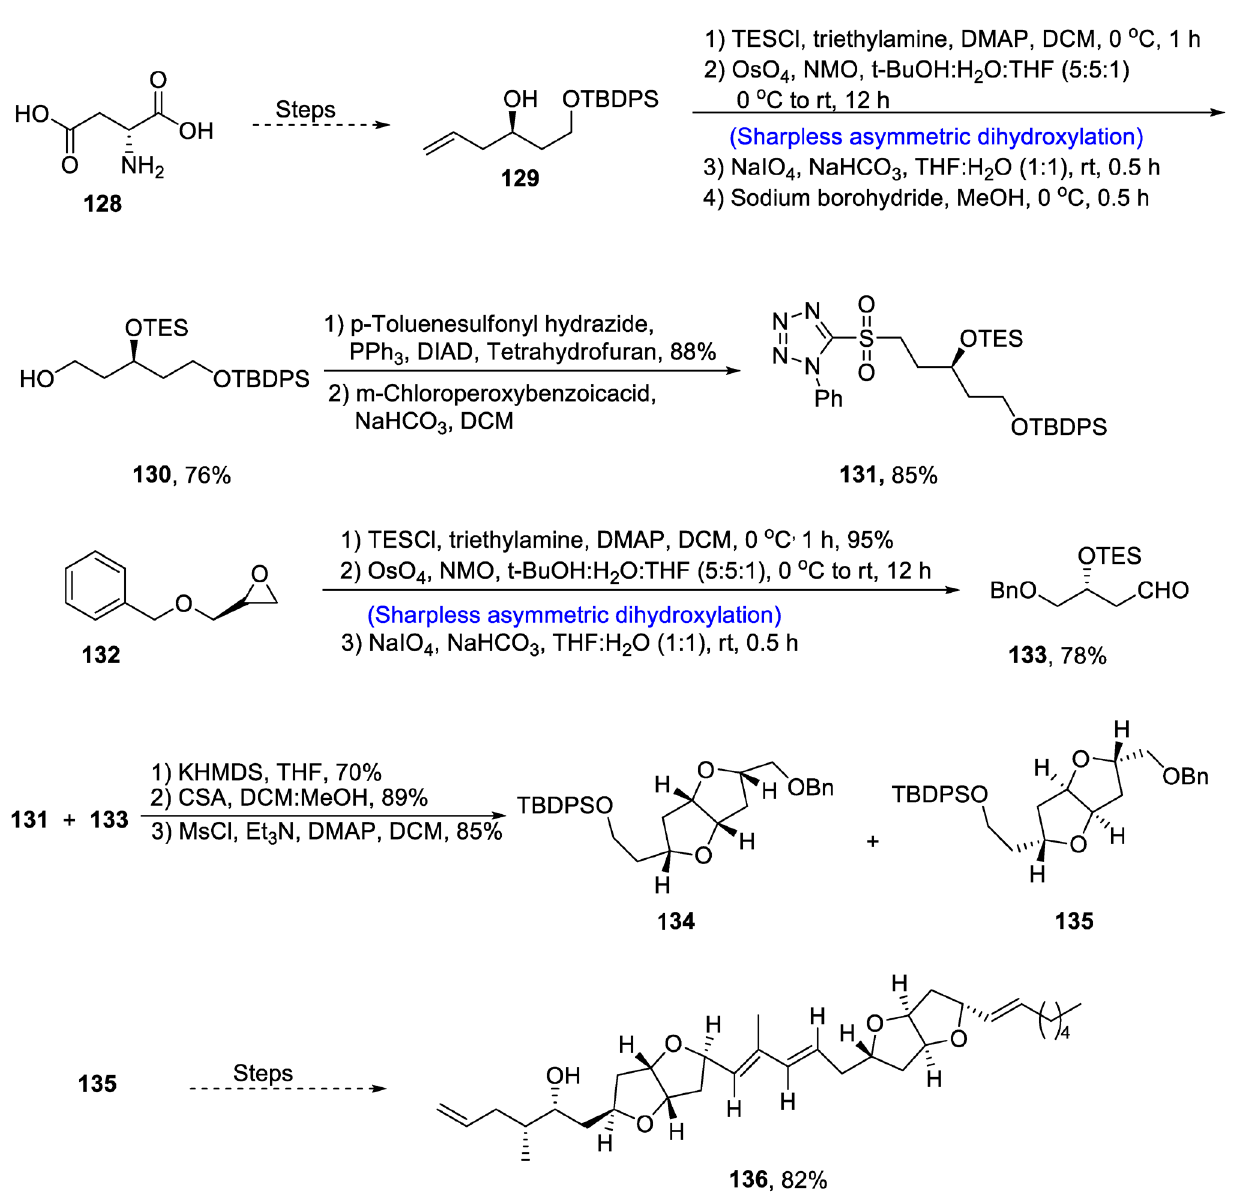
Scheme 19. Synthesis of amphirionin-2 136